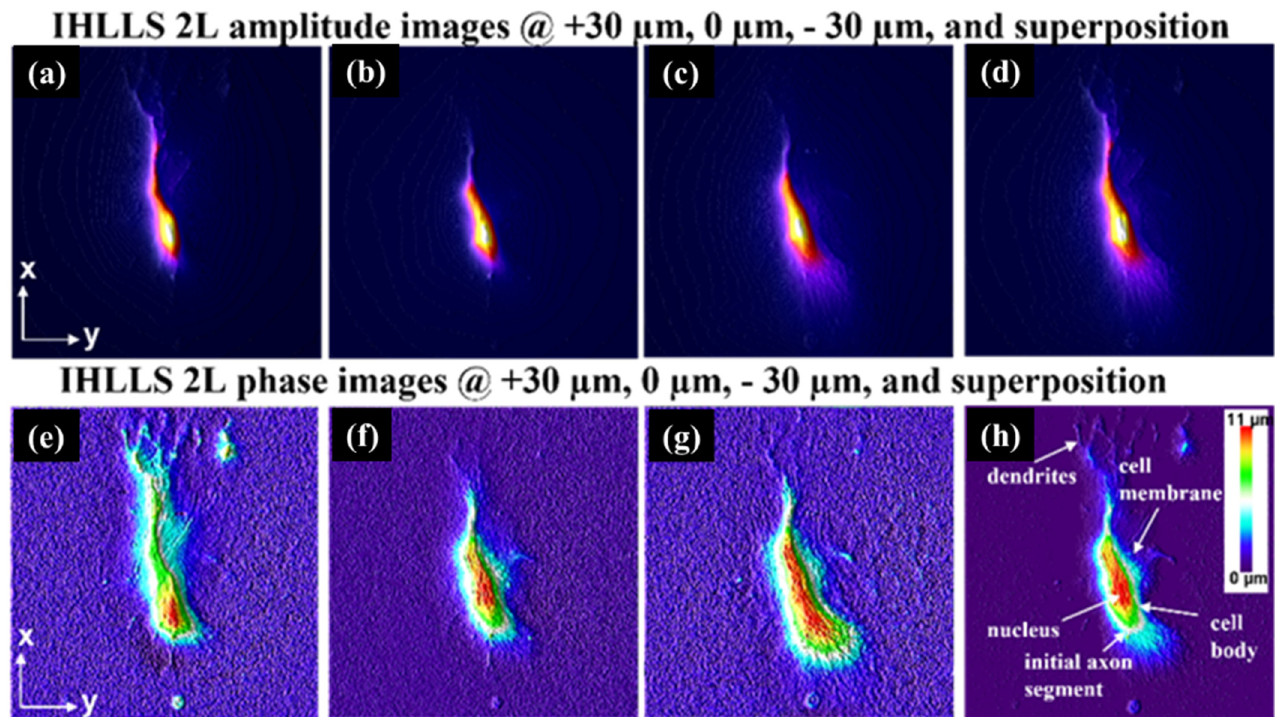
Figure 25. IHLLS 2L imaging of a lamprey spinal cord ventral horn neuron with dendrites; ( a ) Amplitude reconstruction of a neuronal cell at three z-galvo positions: ( a ) +30 µ m, ( b ) 0 µ m, ( c ) − 30 µ m, and ( d ) the superposition of all three; Phase reconstruction of a neuronal cell at z-galvo positions: ( e ) +30 µ m, ( f ) 0 µ m, ( g ) − 30 µ m, and ( h ) the superposition of all three. (Images are taken from [41] with